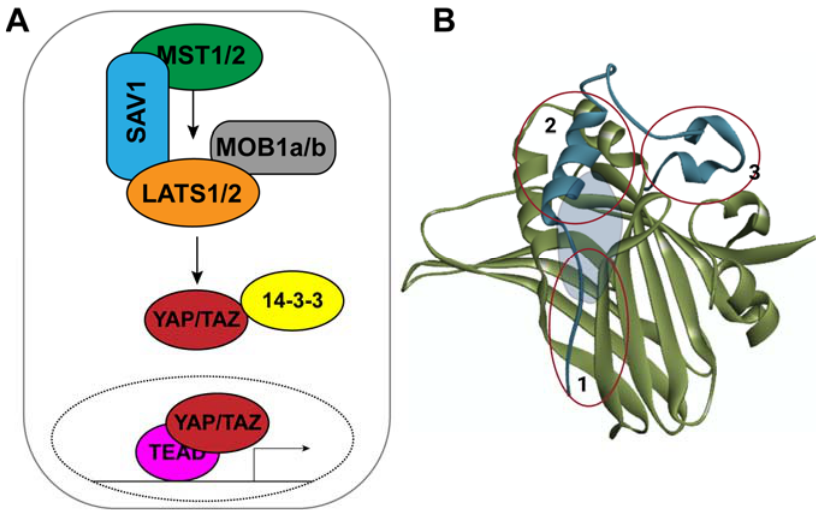
Figure 1. ( A ) Simplified schematic of the Hippo signaling pathway. MST1/2 phosphorylates LATS1/2, which in turn phosphorylates YAP/TAZ. Phosphorylated TAP/TAZ is retained in the cytoplasm by the 14-3-3 proteins. ( B ) Structure of TEAD (green) and YAP (blue) showing the 3 interfaces of interaction and the central hydrophobic pocket in grey.